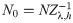
The signal in Bcell1 that successfully reaches the nuclear membrane is sharpened as the inactivation rate, λ, is increased.Here signal denotes the expected rate of arrival of signaling molecules at the nuclear membrane when the number of arriving molecules overall is N. The expected rate of arrival is plotted as a function of the time that has elapsed since the signaling molecules were released uniformly distributed across the interior of the cell membrane. Note that the total number of arriving molecules is being held constant in the results plotted here, and this requires that more signaling molecules be released when λ is greater. This is achieved by choosing the total number of molecules that are released initially as N0=NZλ,h−1. As explained above, in a deterministic model with this initial condition, the signal corresponds to the flux (number of molecules per time) successfully reaching the nucleus (given by Nfλ,h(t)Zλ,h−1). For the single-particle stochastic model (10), we can alternatively define the signal to be fλ,h(t)Zλ,h−1. This corresponds to the single particle’s first passage time density to reach the nucleus, conditional on the molecule arriving before inactivation. The graph of this function is mathematically equivalent to the preceding figure with the units N = 1 on the y-axis. A similar signal sharpening effect is observed in Bcell2 and Bcell3, see Fig H of S1 Text.